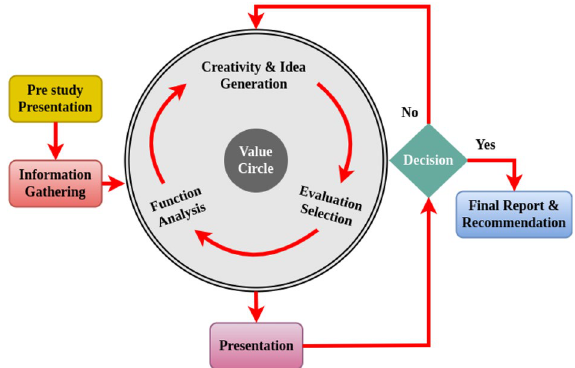
Figure 2. The seven phases in value engineering